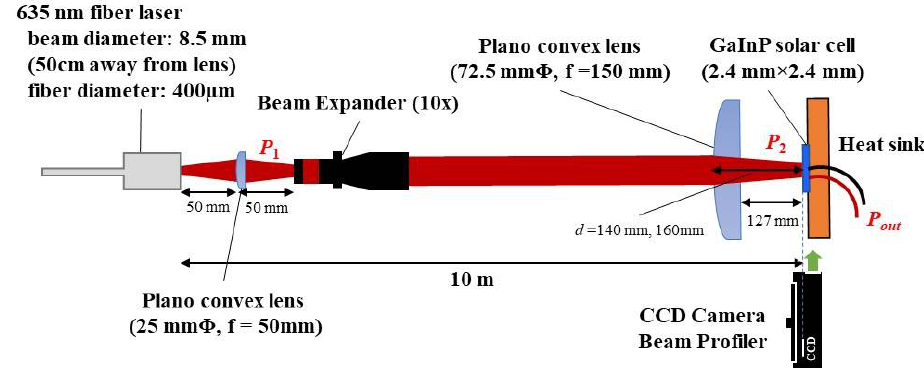
Figure 1. Experimental configuration used for optical wireless power transmission.